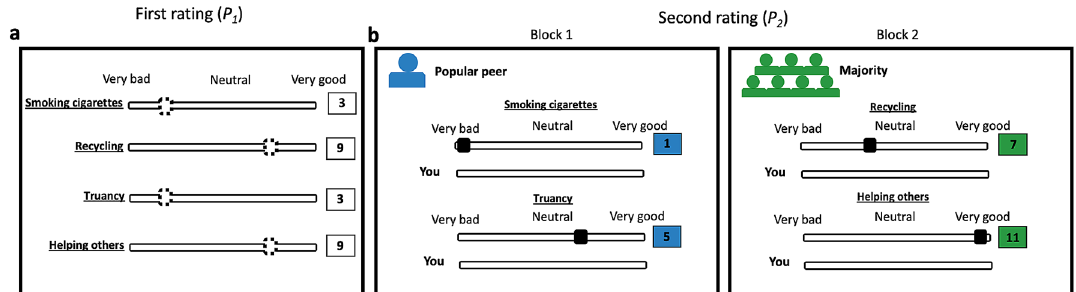
Figure 1. Experimental design. ( a ) In wave 1, we measured participants’ personal norms ( P 1 ) as their rating of a set of risky and prosocial behaviours (dotted handle on the sliders; ranging from 1 = very bad to 11 = very good). ( b ) In wave 2, participants observed normative information ( NI ) and rated their personal norms again ( P 2 ). Our key variable of interest is the peer impact on personal norms, calculated as S = ( P 2 − P 1 )/(NI − P 1 ) . The task included two experimental blocks representing either a popular peer or the majority, and which order